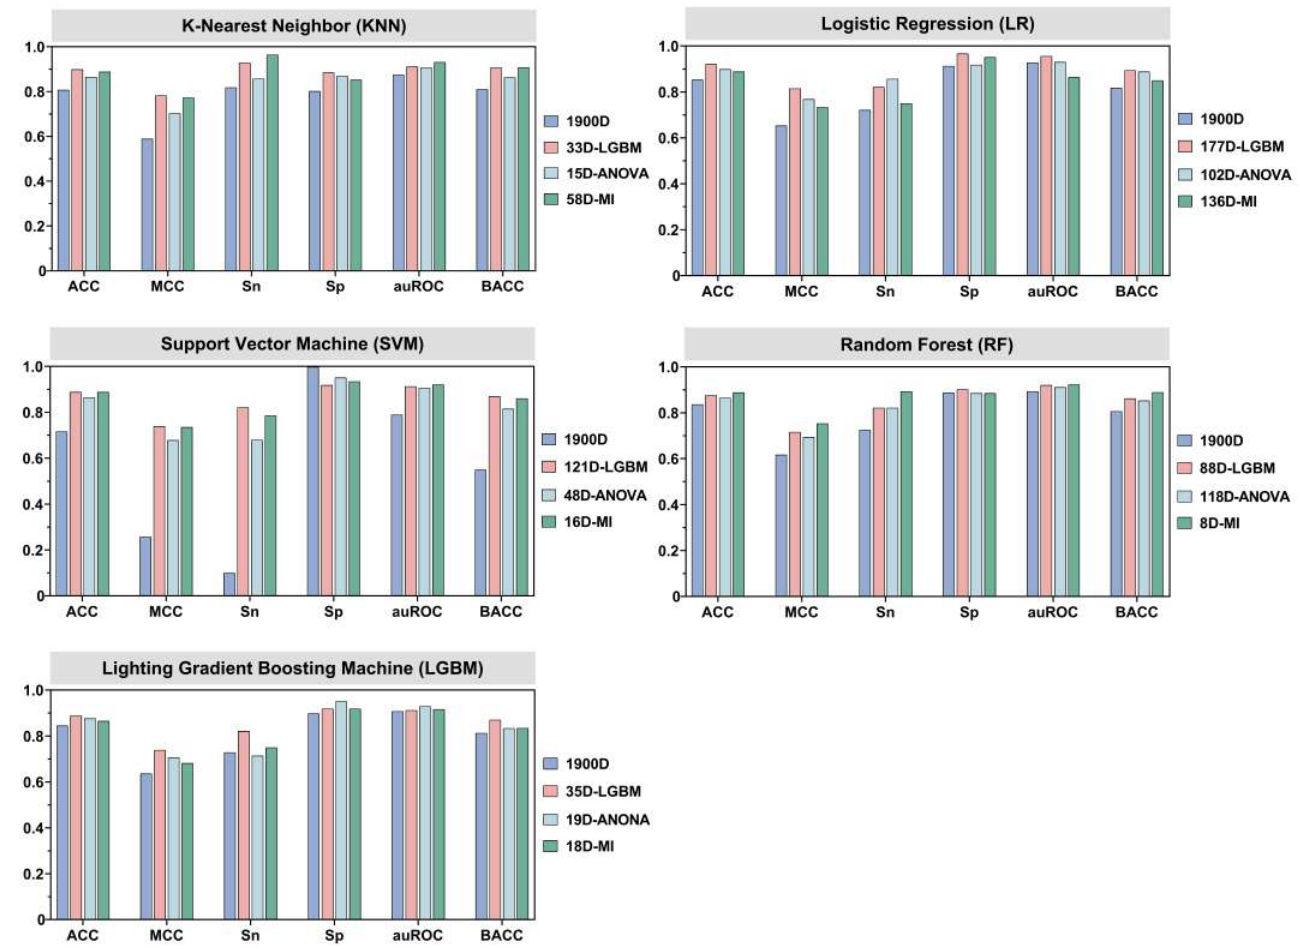
Figure 4. Comparison of the results of independent testing of the models with selected features and the models without selected